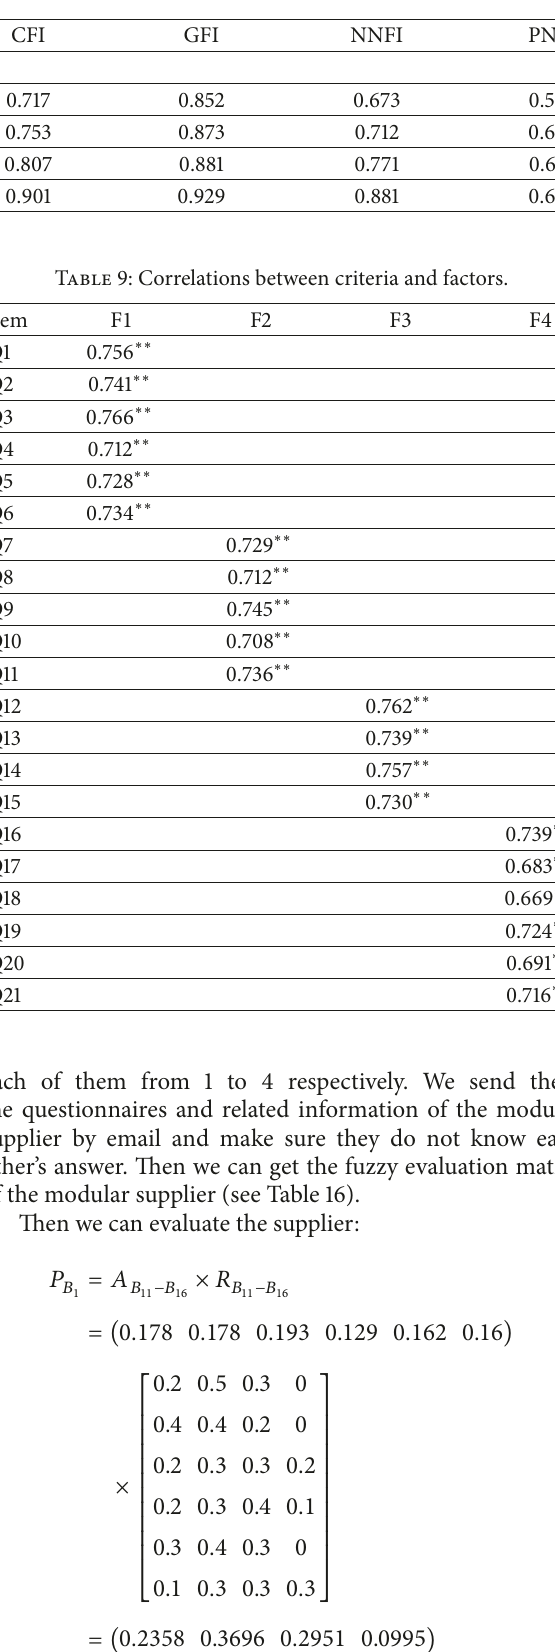
Table 7: Comparison of fit indexes of models.